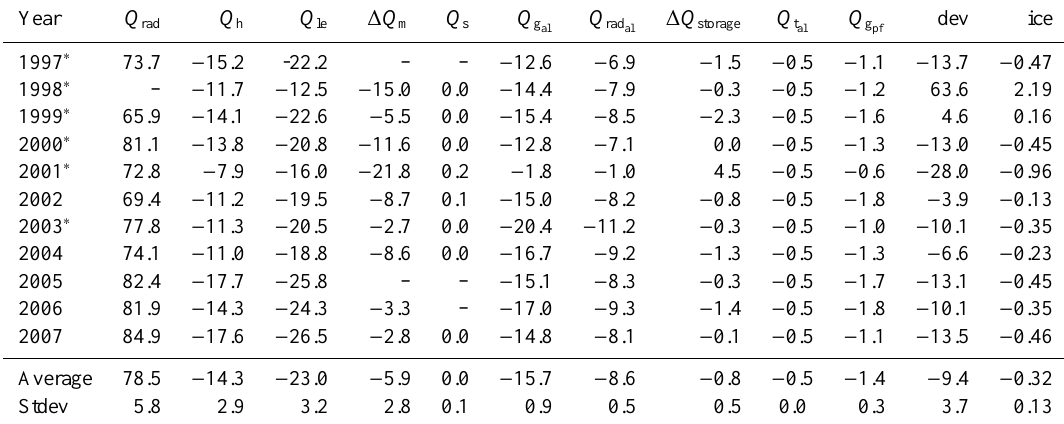
Table 2. Seasonal (June–September) averages of the energy balance components with deviations (in Wm − 2 ) and corresponding ice thickness equivalents (in m). Years marked with an asterik were not considered for the calculation of the average and the standard deviation. Q rad : Net radiation; Q h : Sensible heat flux at the surface; Q le : Latent heat flux at the surface; ∆ Q m : Melt energy in the snow cover; Q s : Conductive heat flux through the snow; Q g : Conductive heat flux within the active layer; Q rad : Net radiation in the active layer; ∆ Q storage : Change in heat al al content in the active layer; Q t : Turbulent heat flux in the active layer; Q g : Conductive heat flux through the permafrost table; dev: Energy al pf balance closure; ice: Ice melt equivalent of the energy balance